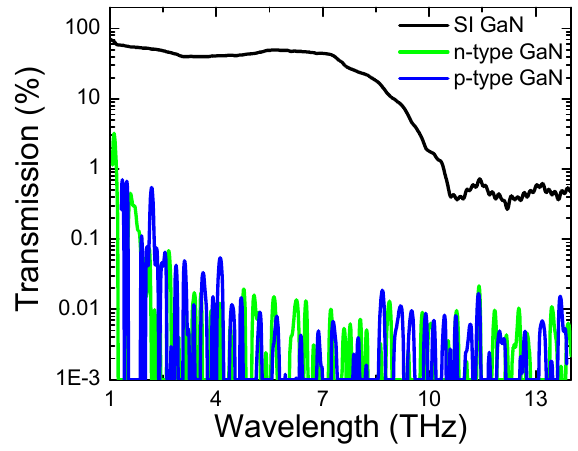
Figure 5. Transmission spectra of SI (black line), n-type (green line), and p-type (blue line) GaN substrates measured at room temperature in the THz spectral range.